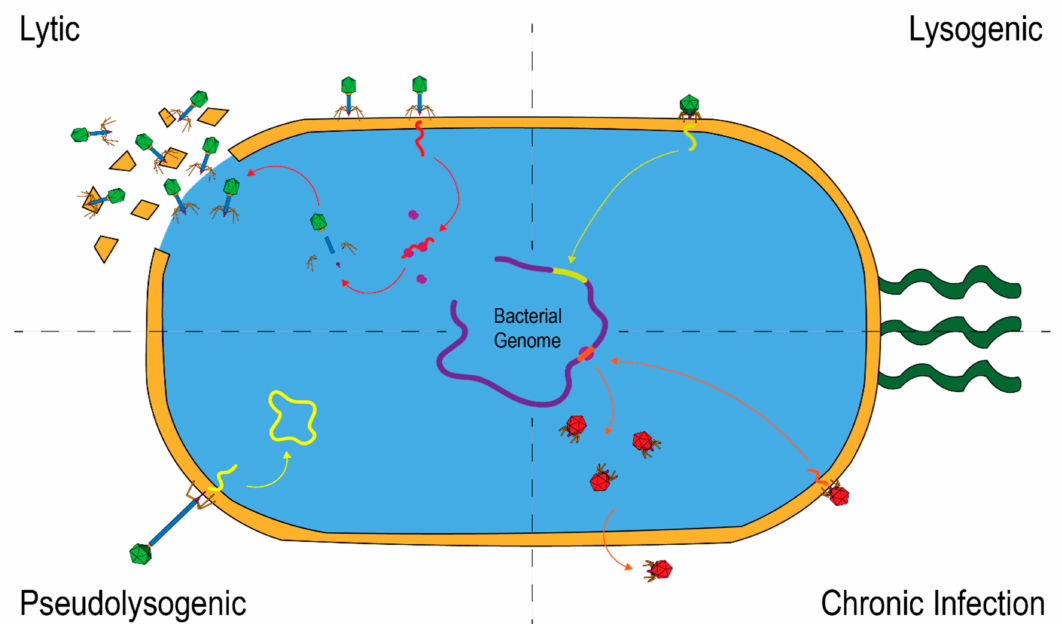
Figure 1. An illustration of the four most well-studied phage lifecycles. Lytic lifecycles involve active replication of the phage and eventual lysis of host bacteria. Lysogenic phages integrate into the host genome or insert as plasmids and do not replicate. Chronic infection produces viral progeny but does not lyse the cell. Phages in a pseudolysogenic state insert DNA, which remains circularized in the